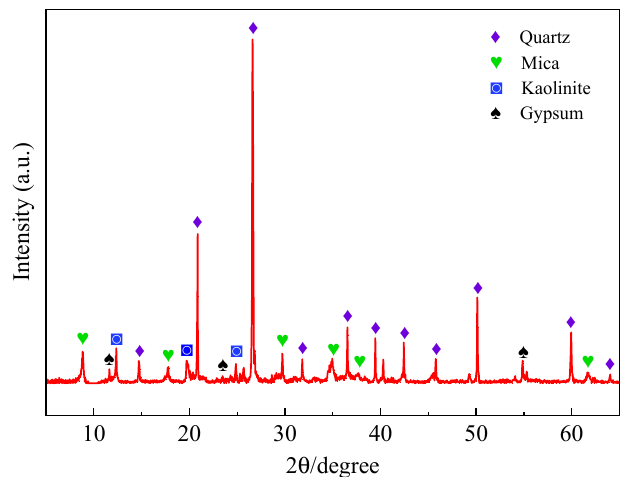
Figure 3. The XRD pattern f MTS.